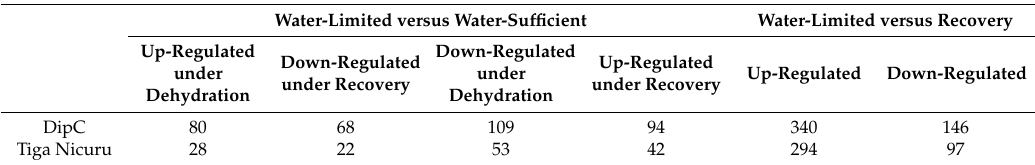
Table 2. Differentially expressed gene